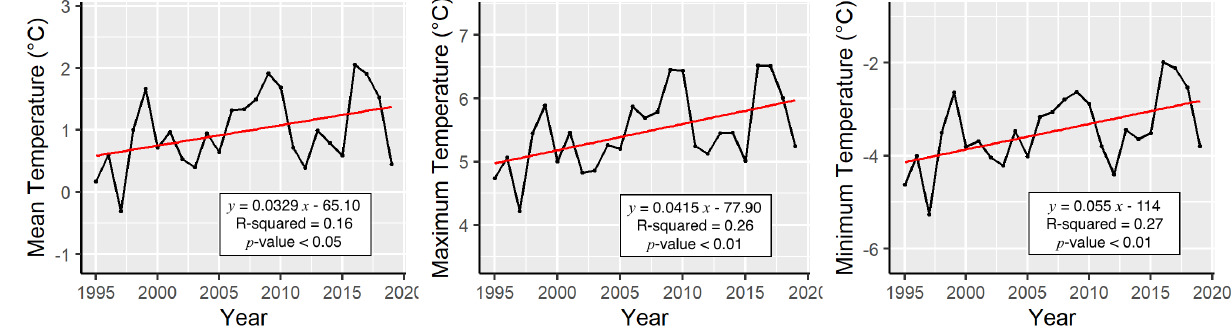
Figure 4. Linear regression trends of annual temperatures.